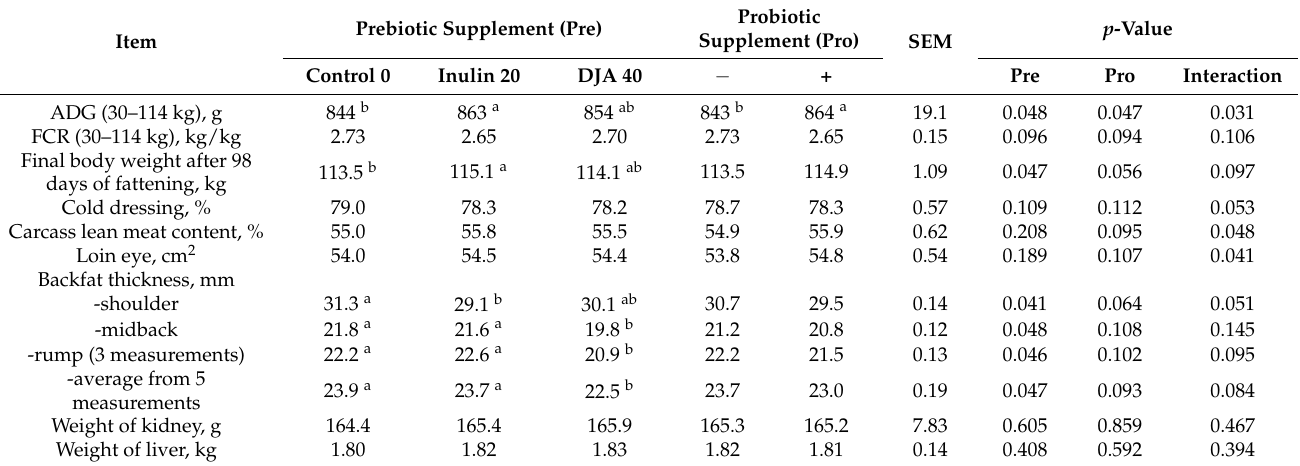
Table 3. Selected indicators of fattening and slaughter analysis of carcasses.